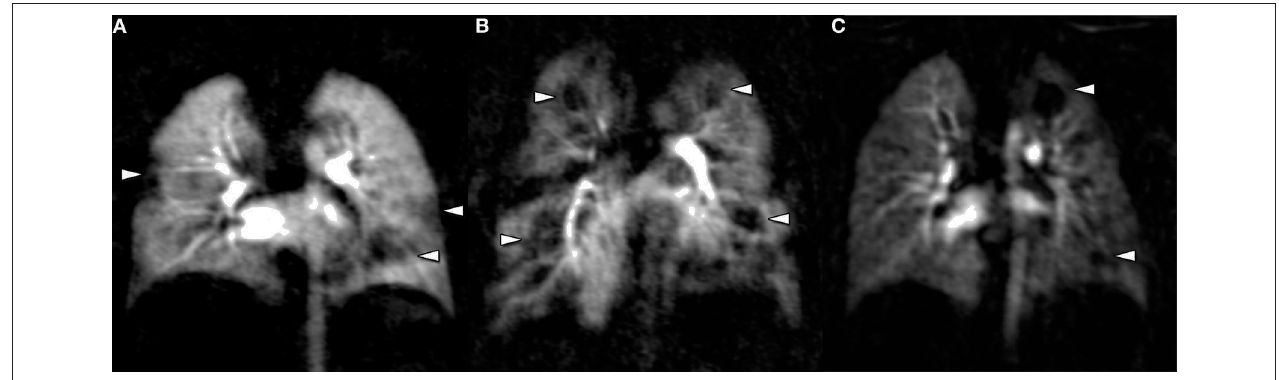
FIGURE 1 | Perfusion MRI is a ready-to-use technique to study functional impairment in pediatric lung disease, based on gadolinium enhancement. Perfusion abnormalities can be found in conjunction with structural lung disease in cystic fibrosis (A) , Langerhans cell histiocytosis (B) , or bronchopulmonary dysplasia (C) . Of note, perfusion abnormalities are non-specific and must be reviewed together with morphological imaging